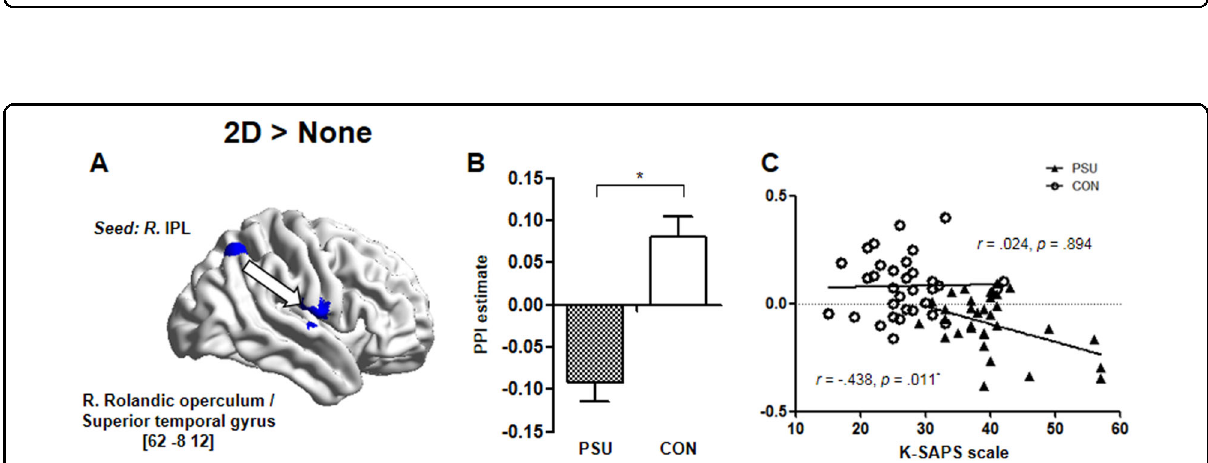
Fig. 3 The brain activation patterns and the correlation between the activation and task performance. The activation patterns in the A right IPL and B MFG in each condition that was different between the two groups. * Signi fi cant at p < 0.05. C The correlation between the right IPL activation and the task performance in each condition. The task performance was presented as the inverse score of the inverse ef fi ciency score (IES) for visualization. ** Signi fi cant at p < 0.0125, corrected.